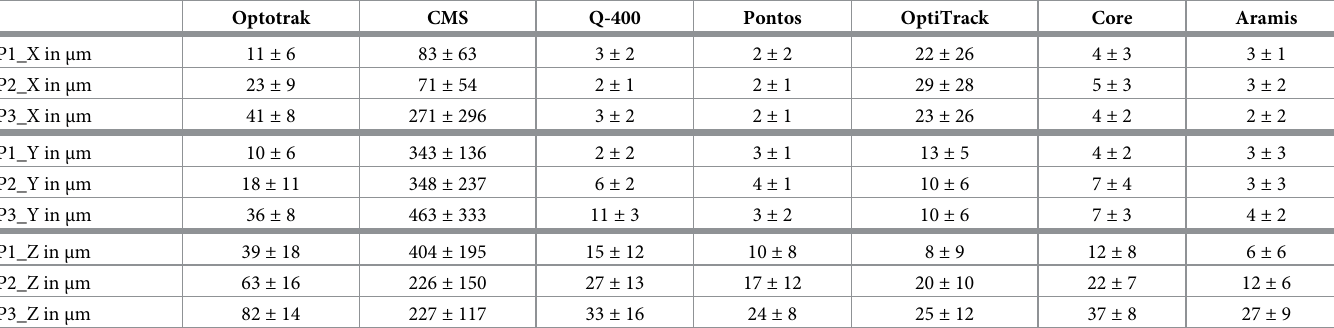
Table 6. Numerical translational measurement errors of the seven systems when using the manual reference device.